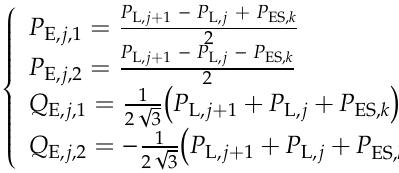
Figure 10. Power quality improvement by EPTD.